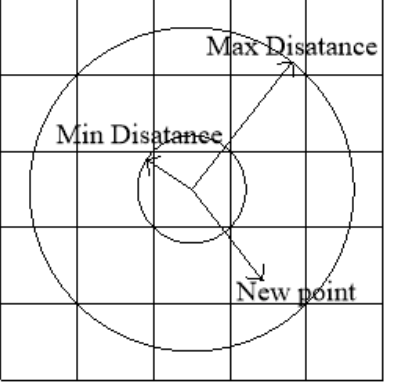
Figure 1. Poisson-disk sampling.